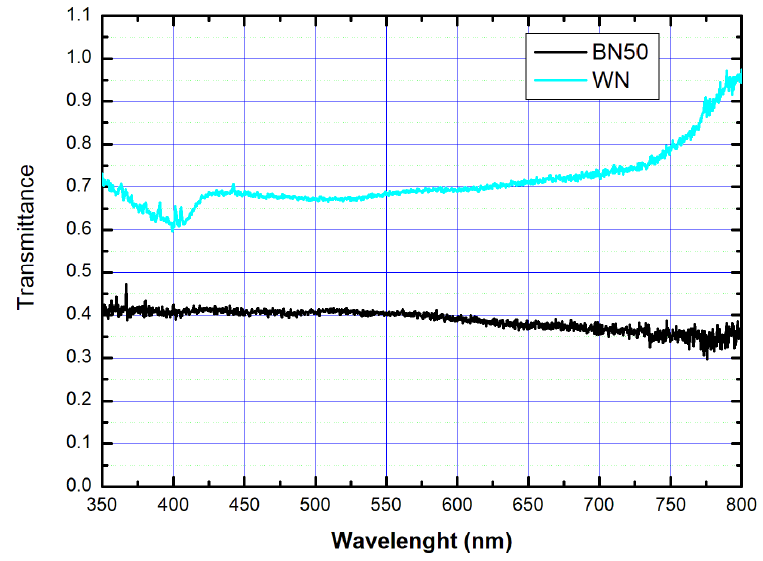
Figure 5. Transmitted radiation proportion between 350 to 800 nm for BN50 and WN treatments (Black Net 50% and White Net, respectively).